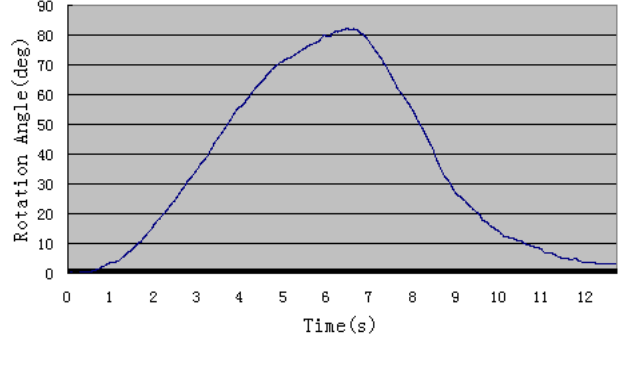
Figure 9. Motor current.